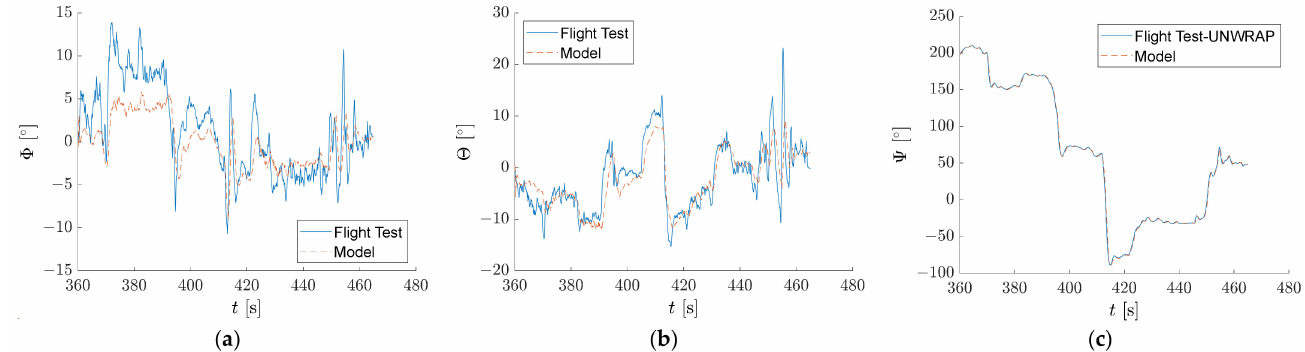
Figure 14. Euler angles: ( a ) roll, ( b ) pitch, and ( c ) yaw. The maximum flight attitude was 30 m (Figure 13c).